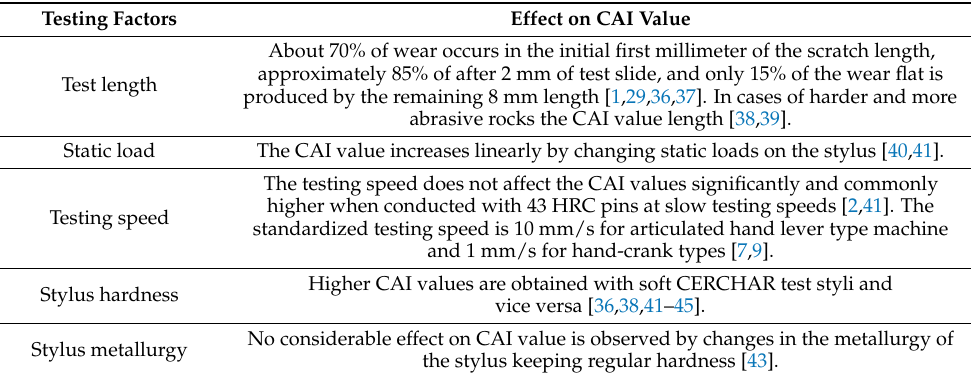
Table 3. Effect of some Cerchar test parameters on the measured values of CAI [35].